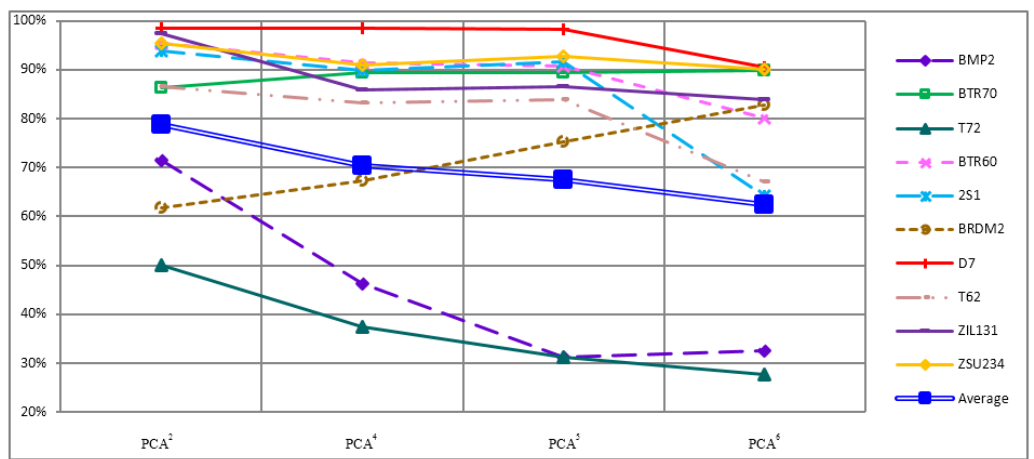
Figure 7. The recognition rates of SRC under PCA feature spaces; PCA 2 refers to reducing the dimensions of the cropped image to a size of 100 by PCA; similarly, PCA 4 , PCA 5 and PCA 6 stand for sizes of 400, 900 and 1600, respectively.